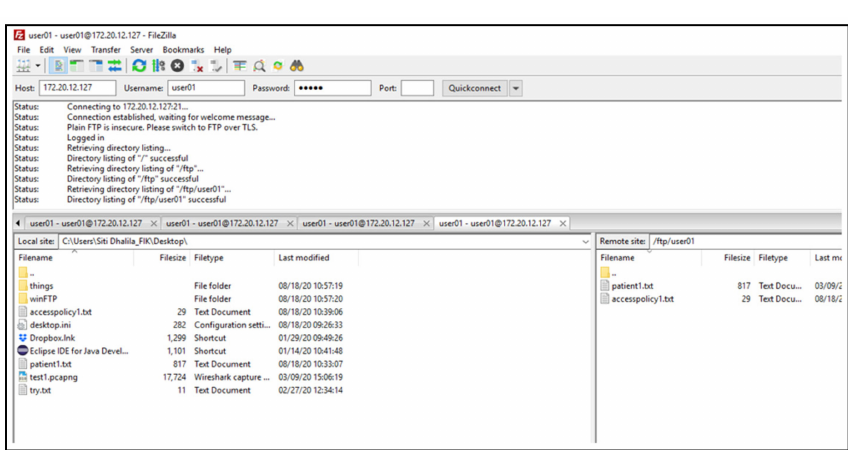
Figure 5. Passive Attack Architecture.